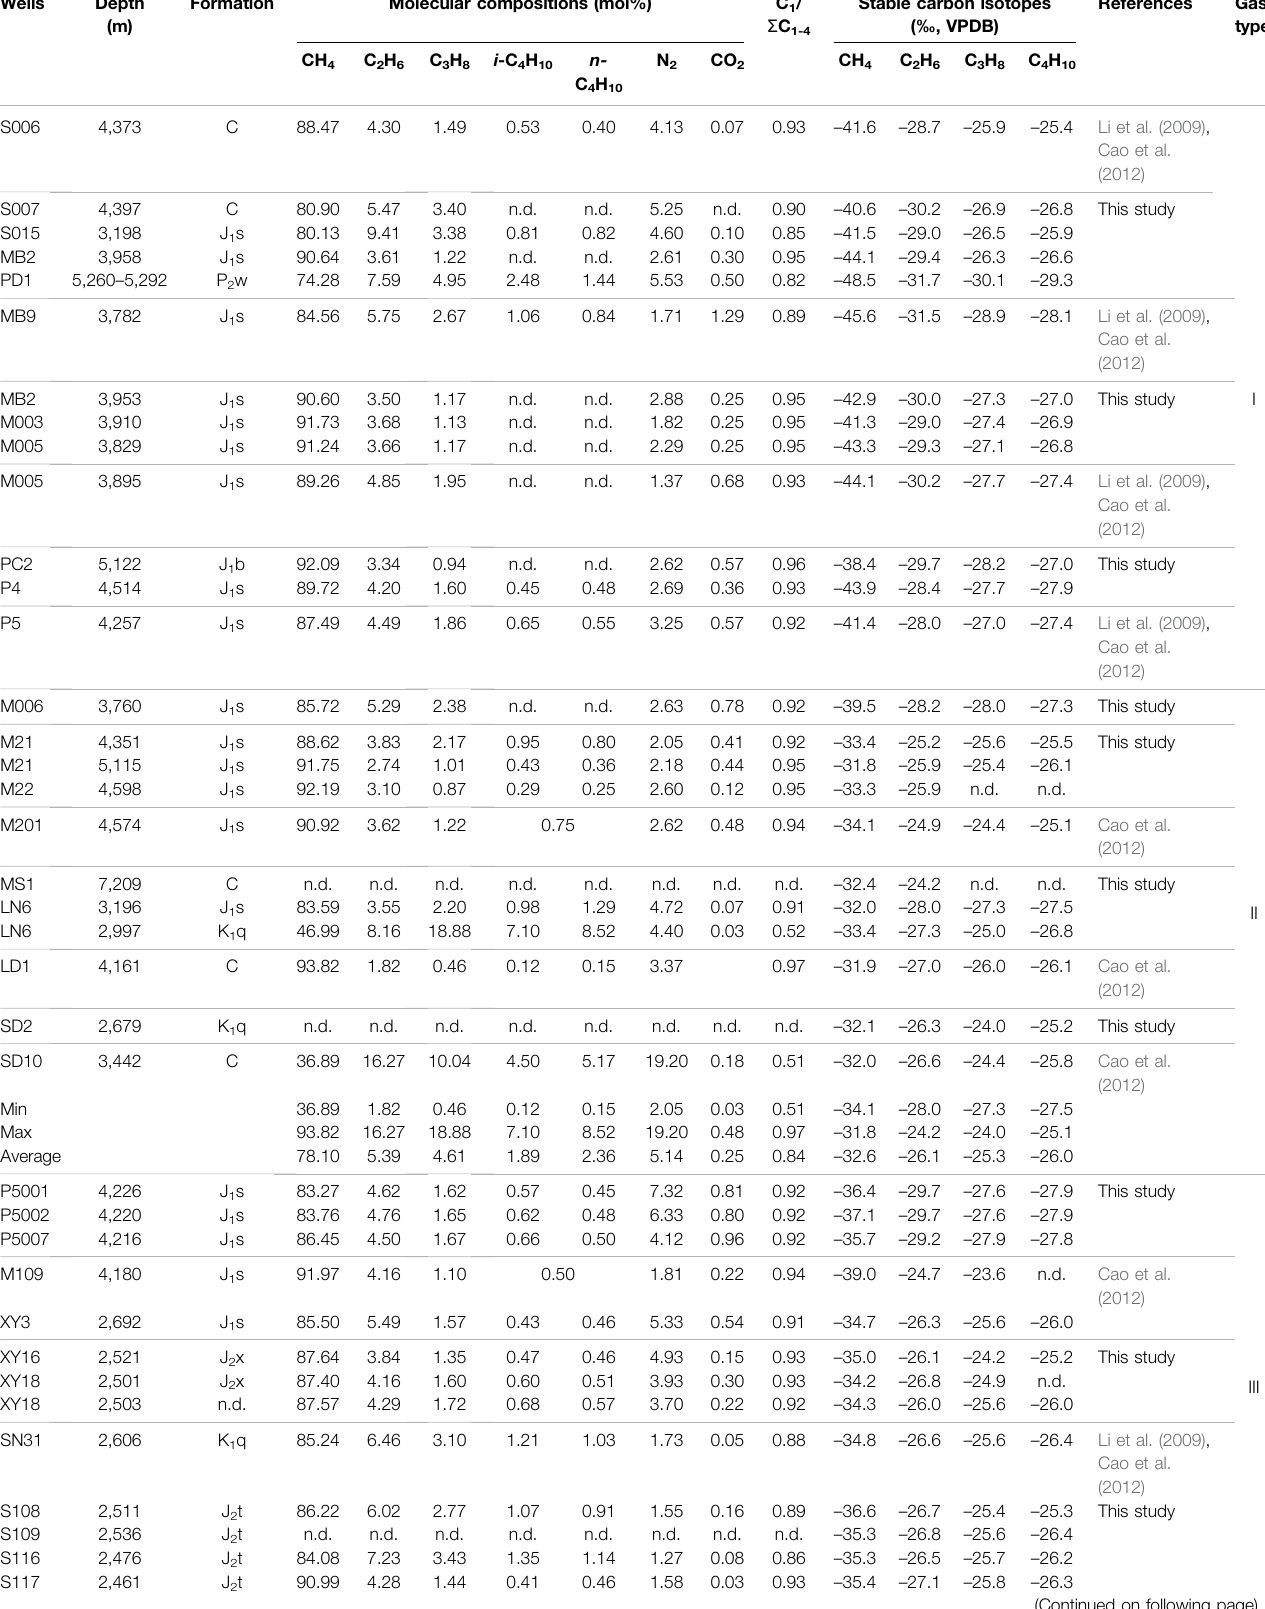
TABLE 1 | Molecular and stable carbon isotopes of natural gases in the central Junggar Basin. Wells Depth